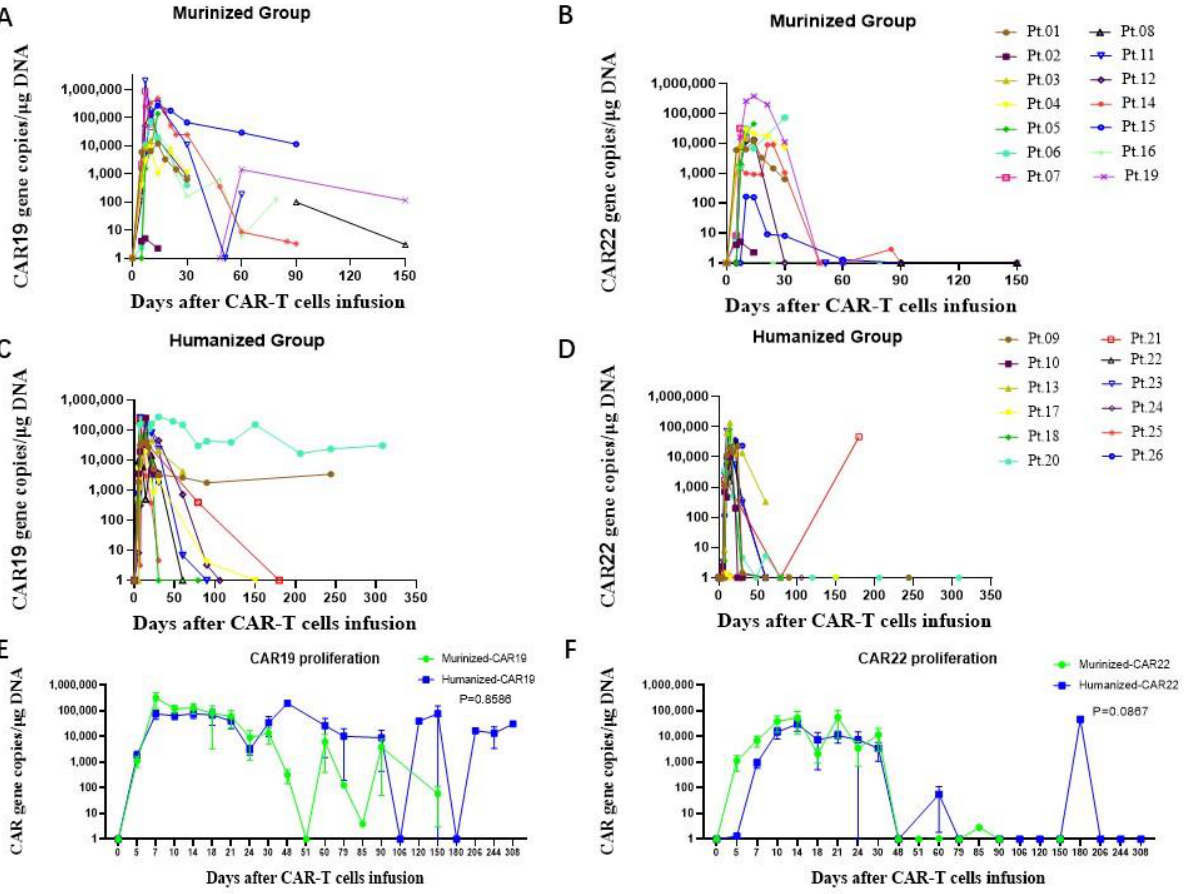
Figure 9. CAR-T cell proliferation in PB measured by qPCR. In the murinized group, ( A ) the median peak of circulating CD19 CAR- T cells, detected by qPCR, was 106,000 copies/μg genomic DNA (range: 5.07 – 2,090,000), occurring on day 10 (range: day 7 – day 60); ( B ) the median peak for CD22